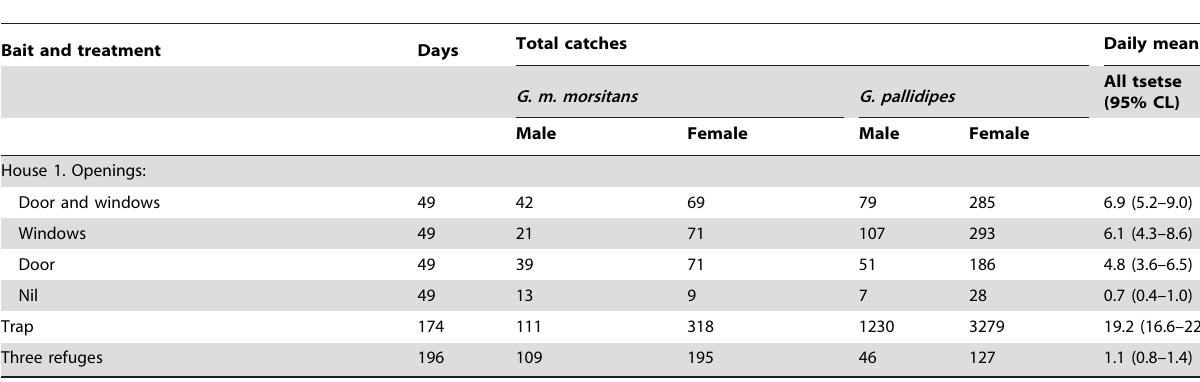
Table 1. Catches from various treatments of House 1, and from a trap and refuges.